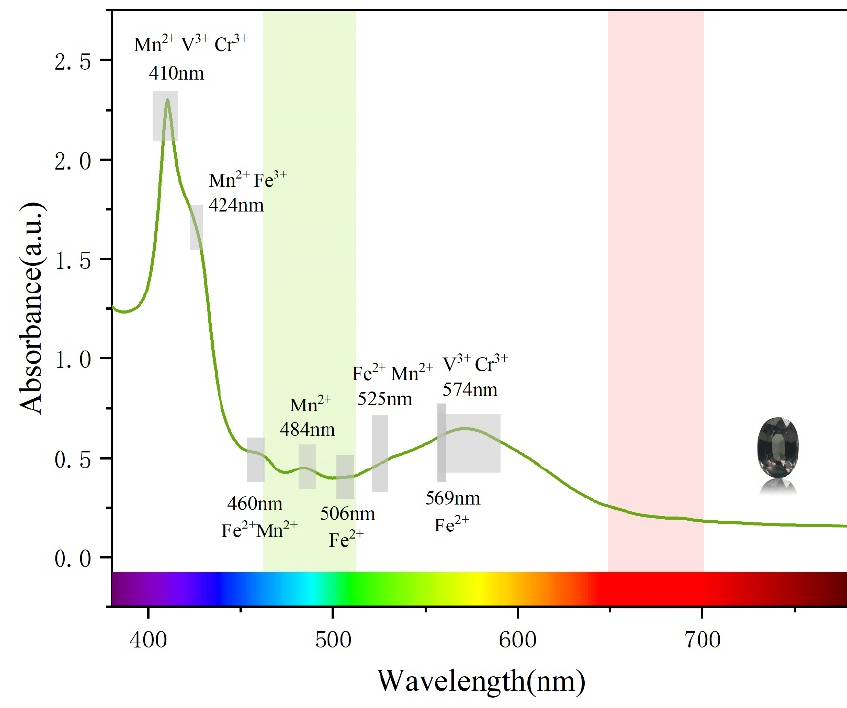
Figure 4. UV-Vis specturm of the colour-changing garnet sample B3 (Two transmission windows appear at 460–510 and 650–700 nm).